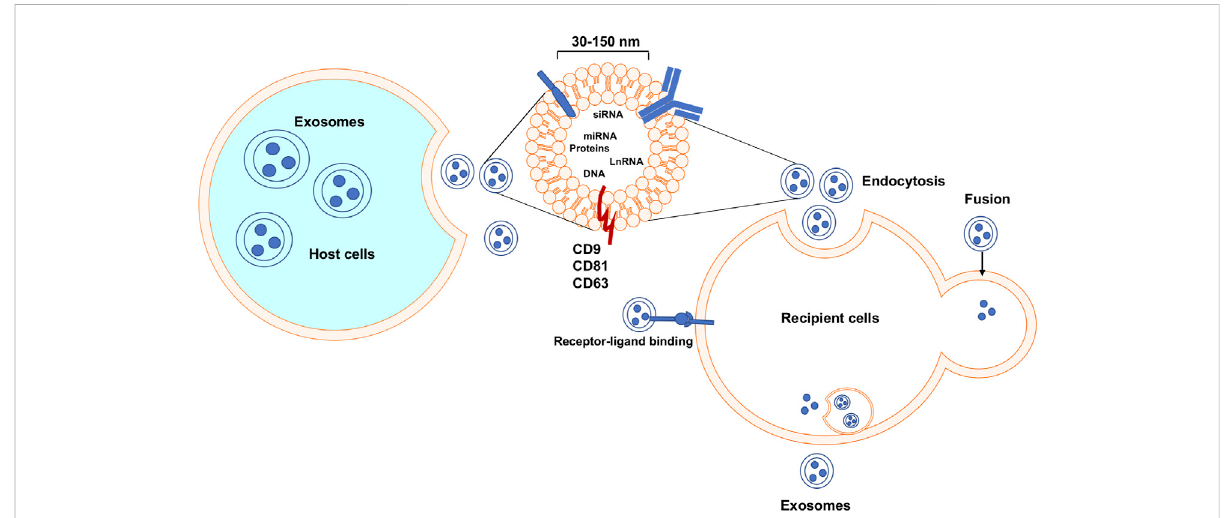
FIGURE 1 Exosomes biogenesis, secretion, uptake, and release of their contents. Exosomes are released after the fusion of a multivesicular body and cell membrane. Exosomes can enter recipient cells via multiple mechanisms and then may play essential roles in many molecular processes.